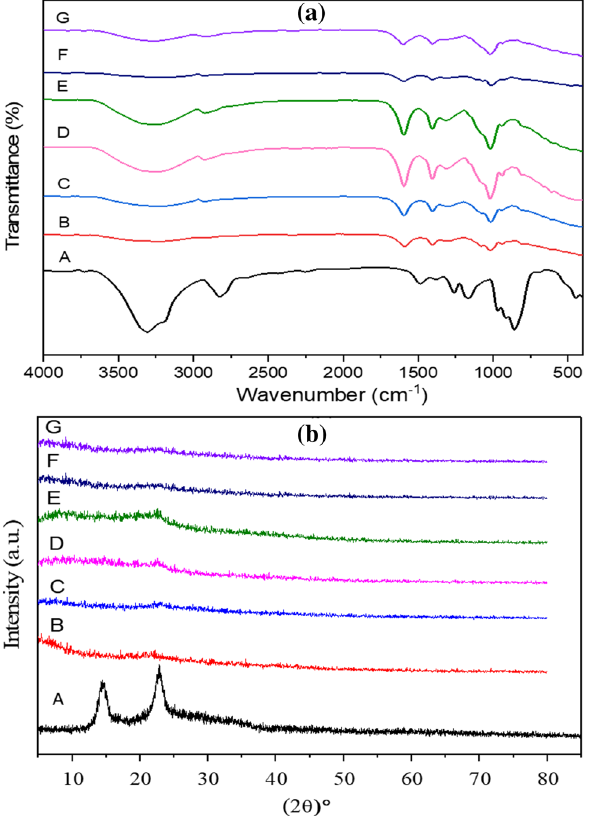
Figure 7. FT-IR ( a ) and XRD spectra ( b ) of [BC (A), SA (B), BC/SA (C), BC/SA/GM1 (D), BC/SA/GM2 (E), BC/SA/GM3 (F), and BC/SA/GM4 (G)].